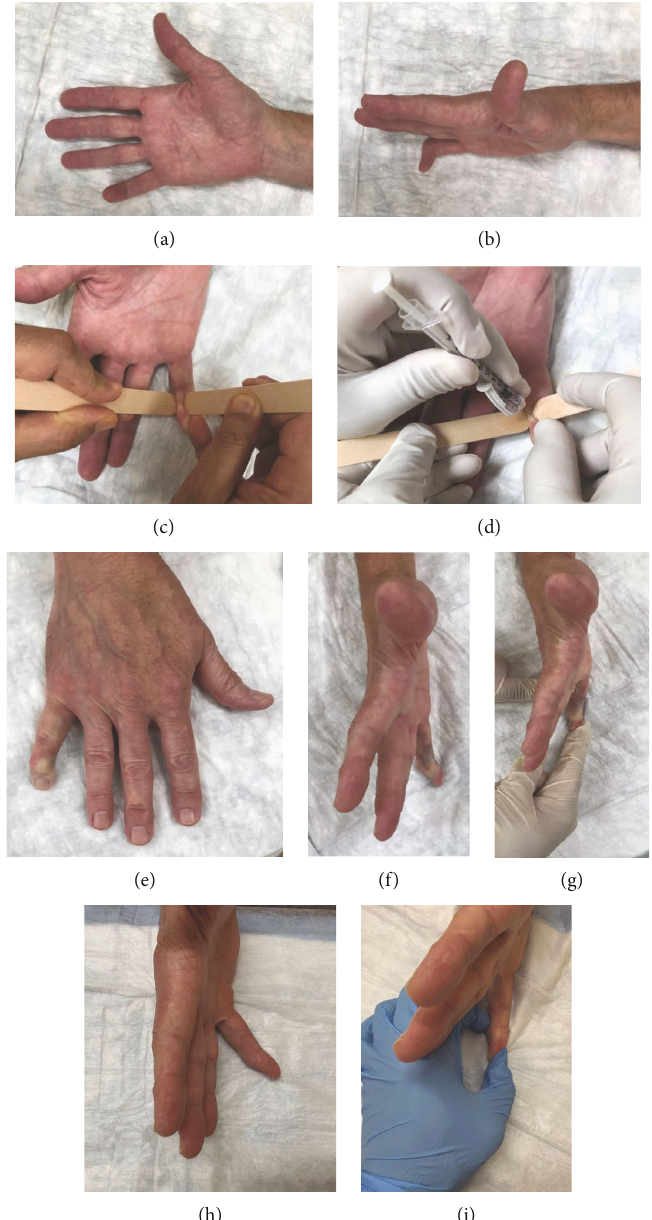
Figure 1: Dupuytren ’ s contracture cord of the DIP joint (a, b). Injection of Dupuytren ’ s contracture cord (c, d). Postinjection results (e – g). Postinjection results at 5 months (h,